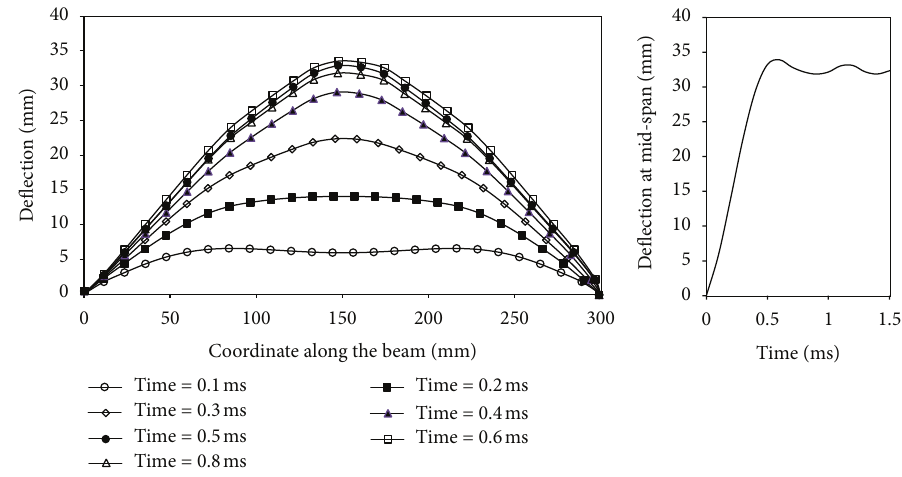
Figure 10: The deflection curve of a 12mm aluminum beam subjected to an explosion.